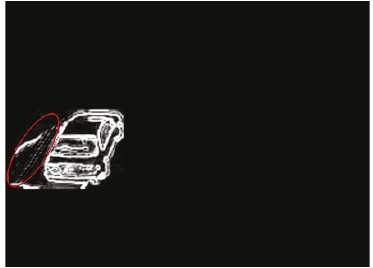
Figure 7: The result of subtracting BI edge from MI edge MBR